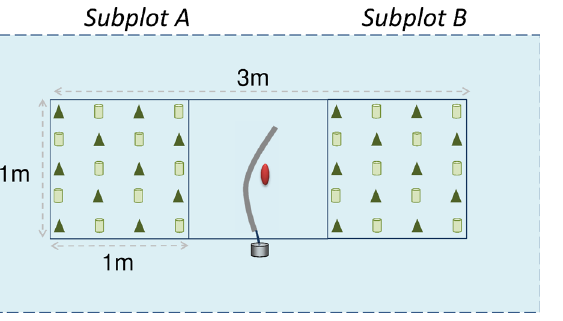
Fig 1. Plot design. Red dot = temperature logger; tube = air-collecting silicon tube inserted in humus layer; triangle = Norway spruce seedling; can = Scots pine seedlings; blue area = treated